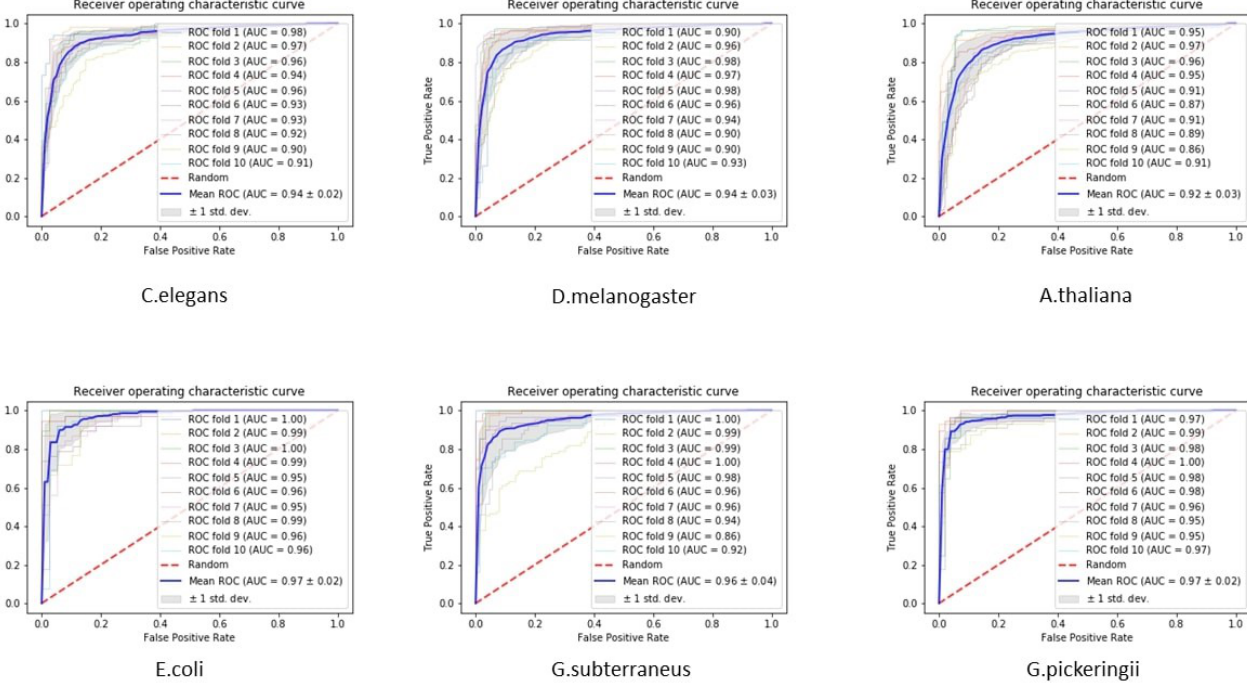
Figure 3. Demonstration of the test dataset receiver operation characteristic curve (ROC) of the ten folds and their standard deviation for six